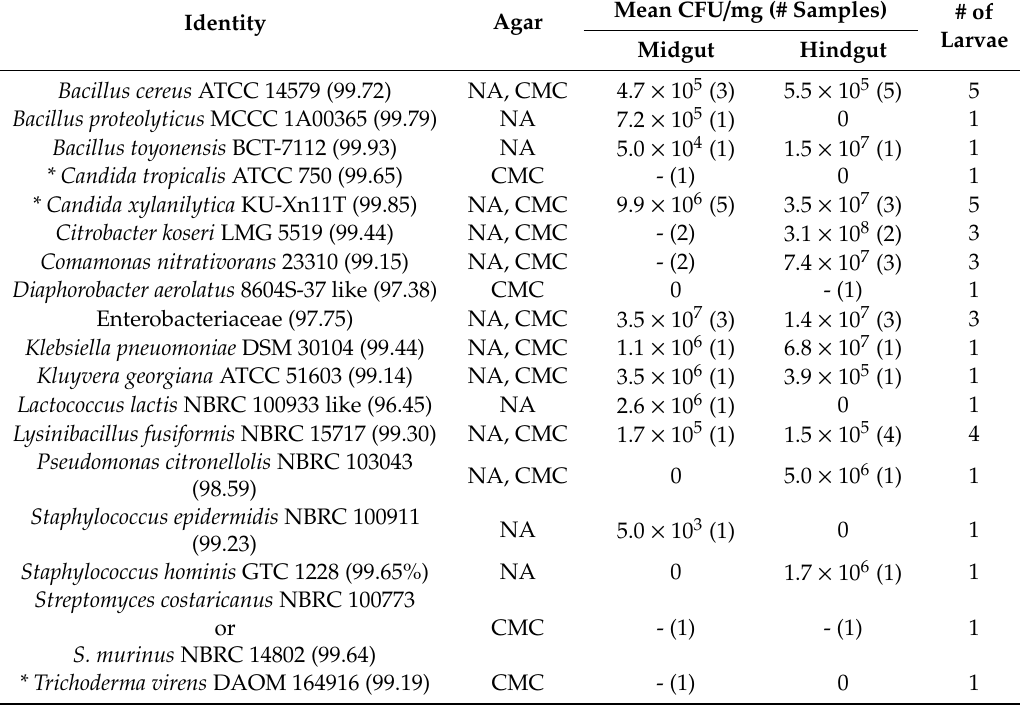
Table 1. Microbes cultured from the midguts and hindguts of larval Oryctes rhinoceros . These microbes were isolated from six larvae whose gut contents were plated into nutrient agar (NA) and carboxymethyl cellulose agar (CMC). Microbe identity given is the closest type specimen in the NCBI RNA database, with sequence similarity in parentheses, except for an Enterobacteriaceae that could not be determined (see results). Microbial density as colony forming units (CFUs) per milligram of midgut or hindgut content is estimated by averaging the CFU / mg of each serial dilution plate with a countable number of colonies of said species, which was only done for NA plates. The ranges varied within an order of magnitude. The number of midgut samples, hindgut samples, and larvae out of six is given. A dash (-) means CFU could not be